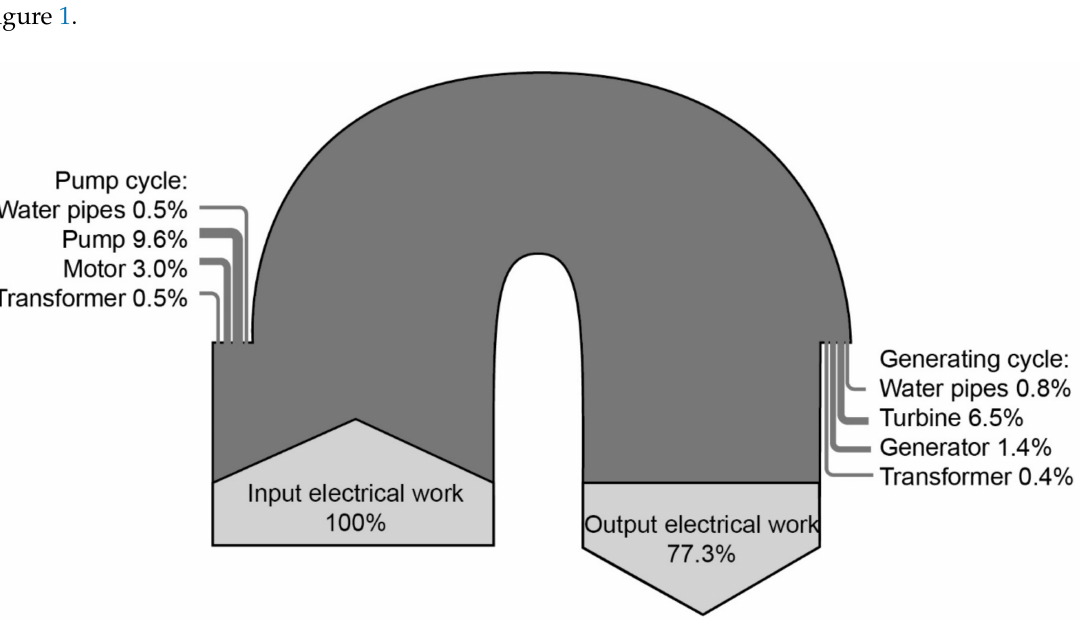
Figure 1. E ffi ciency and energy losses of PHS. Source: own illustration, based on [24].